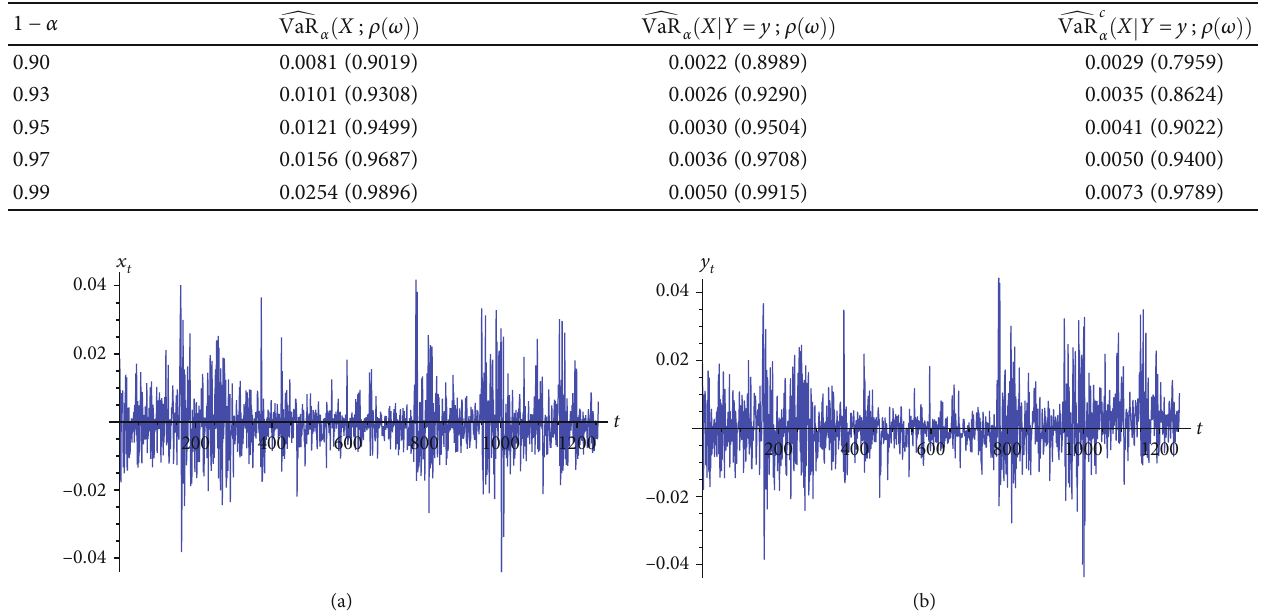
Table 7: The (conditional) estimative VaR forecast and its coverage probability (in the bracket) of the negative daily log-returns of the S&P 500 index, given the negative daily log-returns of the Dow Jones index, with i.i.d. assumption; the conditional estimative VaR forecast in the last column is calculated through t copula.